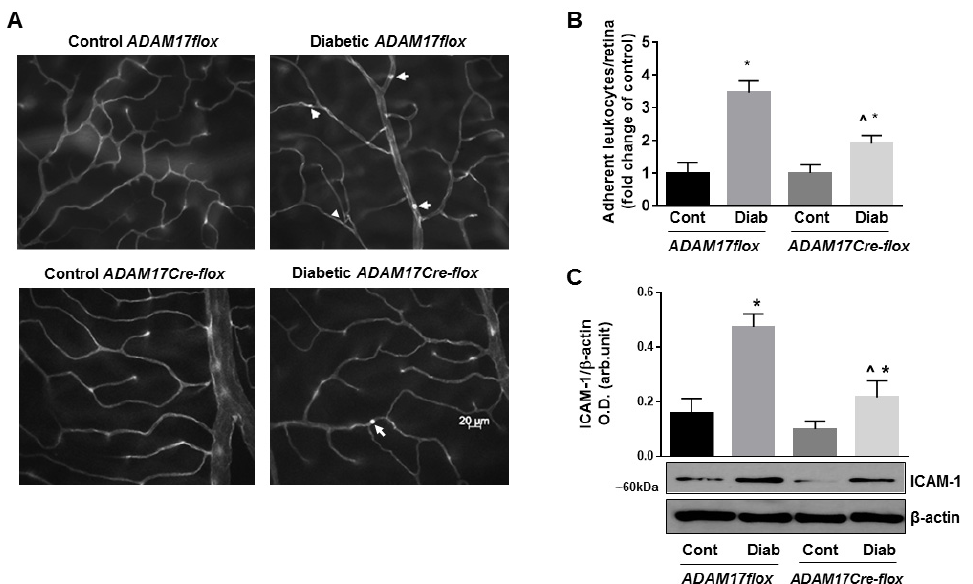
Figure 4. Diabetes-induced retinal leukostasis is reduced in mice with conditional inactivation of ADAM17 in vascular endothelium. ( A ) Representative images of flat-mounted retinas from control normoglycemic and diabetic ADAM17flox and ADAM17Cre-flox mice stained with ConA to identify leukocytes adherent to retinal microvessels (white arrows). Scale bar: 20 µ m. ( B ) Quantification of adherent leukocytes. Data are expressed as adherent leukocytes per retina and presented as a fold change from corresponding controls. * p < 0.05 diabetic vs. corresponding control. ˆ p < 0.05 diabetic ADAM17flox vs. diabetic ADAM17Cre-flox mice. n = 5 in each group. ( C ) Representative blots and densitometry analysis of ICAM-1 protein levels in retinal extracts from control normoglycemic and diabetic ADAM17flox and ADAM17Cre-flox mice. Data presented as mean ± SE. * p < 0.05 diabetic vs. control. ˆ p < 0.01 diabetic ADAM17flox vs. diabetic ADAM17Cre-flox mice. Cont, control; Diab, diabetic. n = 5 per group.